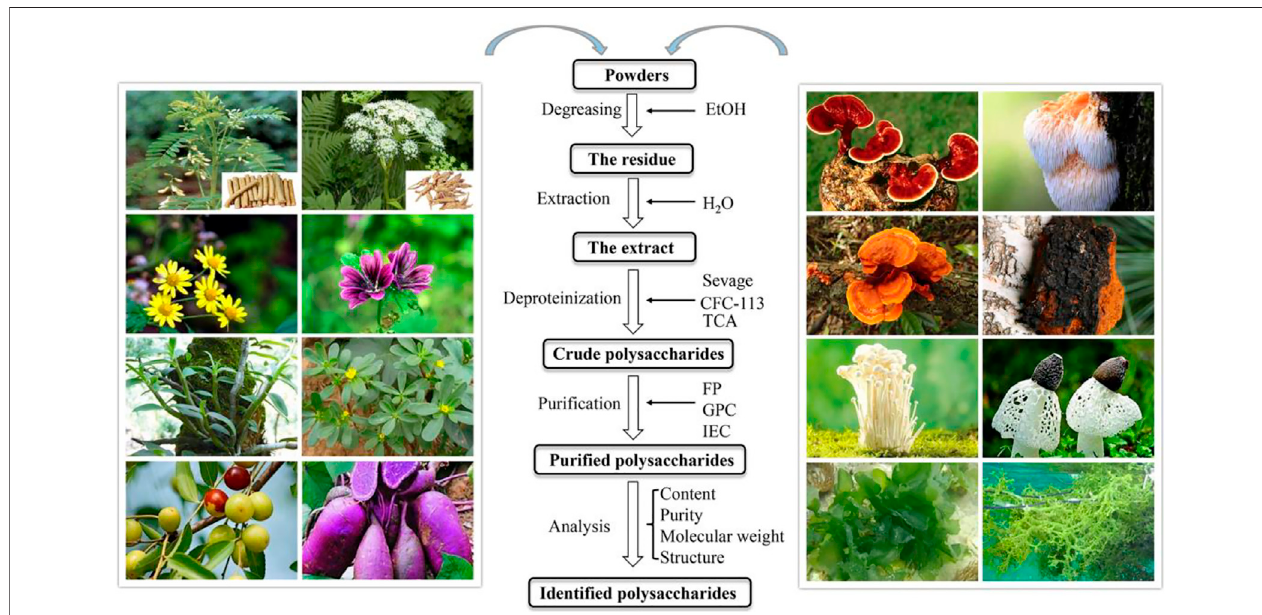
FIGURE 2 | Glance at the natural sources of polysaccharides for the treatment of IBD in the past decades and the essential steps on the isolation and puri fi cation of them.